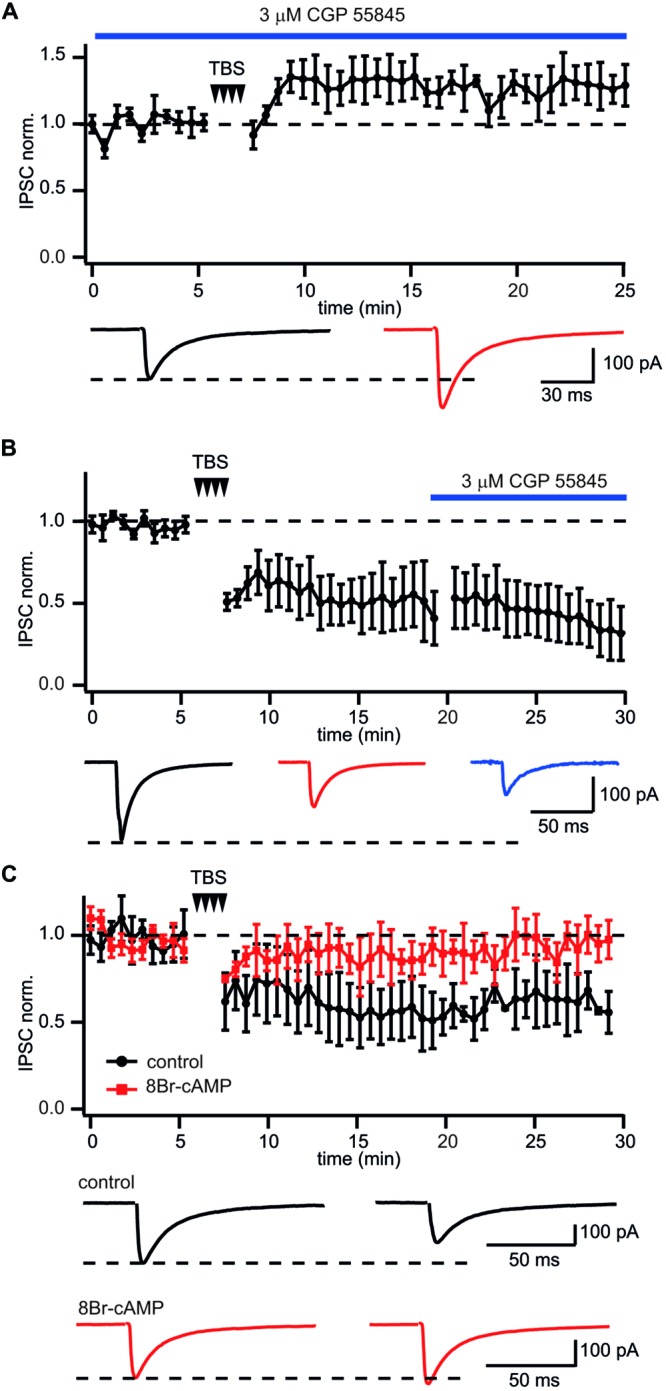
GABABR involved in LTD induction but not maintenance at CB1+ interneuron to CA1 pyramidal cell connections. (A) In CB1+ interneuron to pyramidal cell connections blockade of GABABR prior to TBS occludes LTD and triggers potentiation of IPSCs. The scatter plot summarizes data from five neurons. Traces underneath are averaged IPSCs prior to (black) and 20 min after (red) TBS. (B) Application of the GABABR antagonist CGP55845 after LTD development does not affect IPSC amplitudes. The scatter plot summarizes data from five neurons. Traces underneath are averaged IPSCs prior to (black), after (red) TBS and in the presence of CGP55845 (blue). (C) GABABR dependent suppression of PKA underlies TBS-induced LTD at CB1+ interneuron to pyramidal cell connections. After postsynaptic intracellular administration of the PKA activator 8Br-cAMP TBS fails to induce LTD. The scatter plot compares data obtained with (red squares; n = 5) and without (black circles; n = 10) 8Br-cAMP in the intracellular solution. Traces underneath are averaged IPSCs prior (left) and after (right) TBS. Responses recorded in the presence of 8Br-cAMP are shown in red.